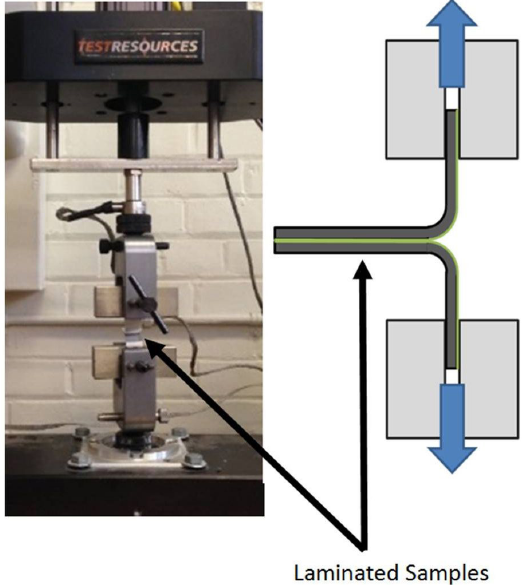
Figure 4. Universal testing machine and the schematic of the peeled sample.